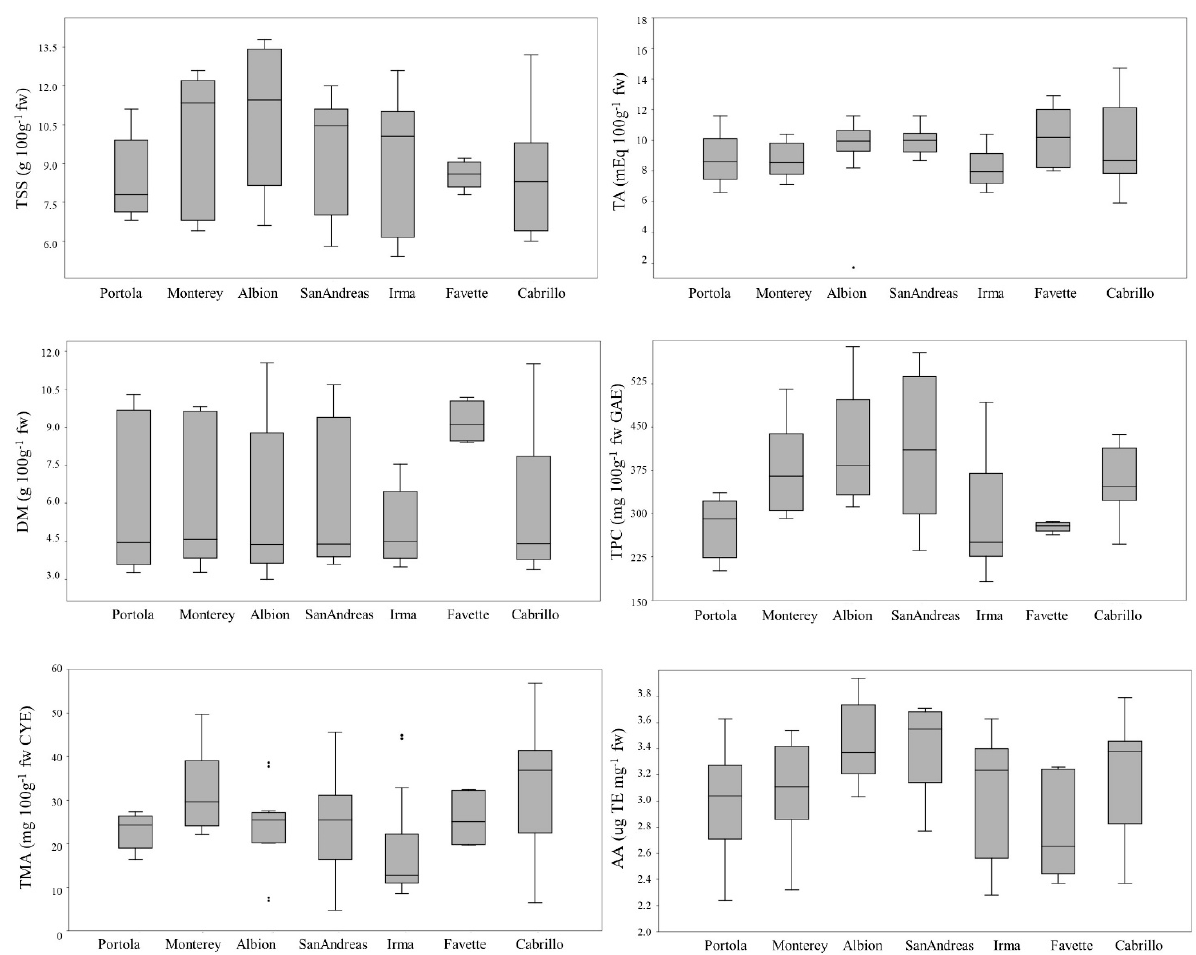
Figure 3. Dataset box plots: evaluation of the chemical traits variability in relation to the different cultivars. TSS = total soluble solid content; TA = titratable acidity; DM = dry matter; TPC = total phenolic content; TMA = total monomeric anthocyanins; AA = antioxidant activity. Favette presented the highest mean TA values (10.2 ± 2.1 mEq 100 g − 1 FW), whereas Irma, Portola and Monterey presented the lowest ones (8.2 ± 1.2, 8.6 ± 1.5, 8.7 ± 0.9 mEq